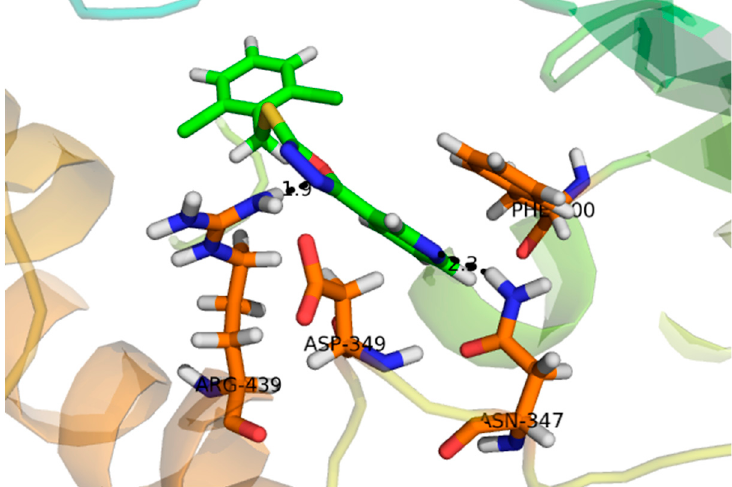
Figure 6. Represents the 3D structures of Compound 4 showing binding potential. Red color in the image shows position of oxygen, green benzene ring, white hydrogen atom, brown color indicates amino acid sequence and blue color indicate nitrogen or amino group.